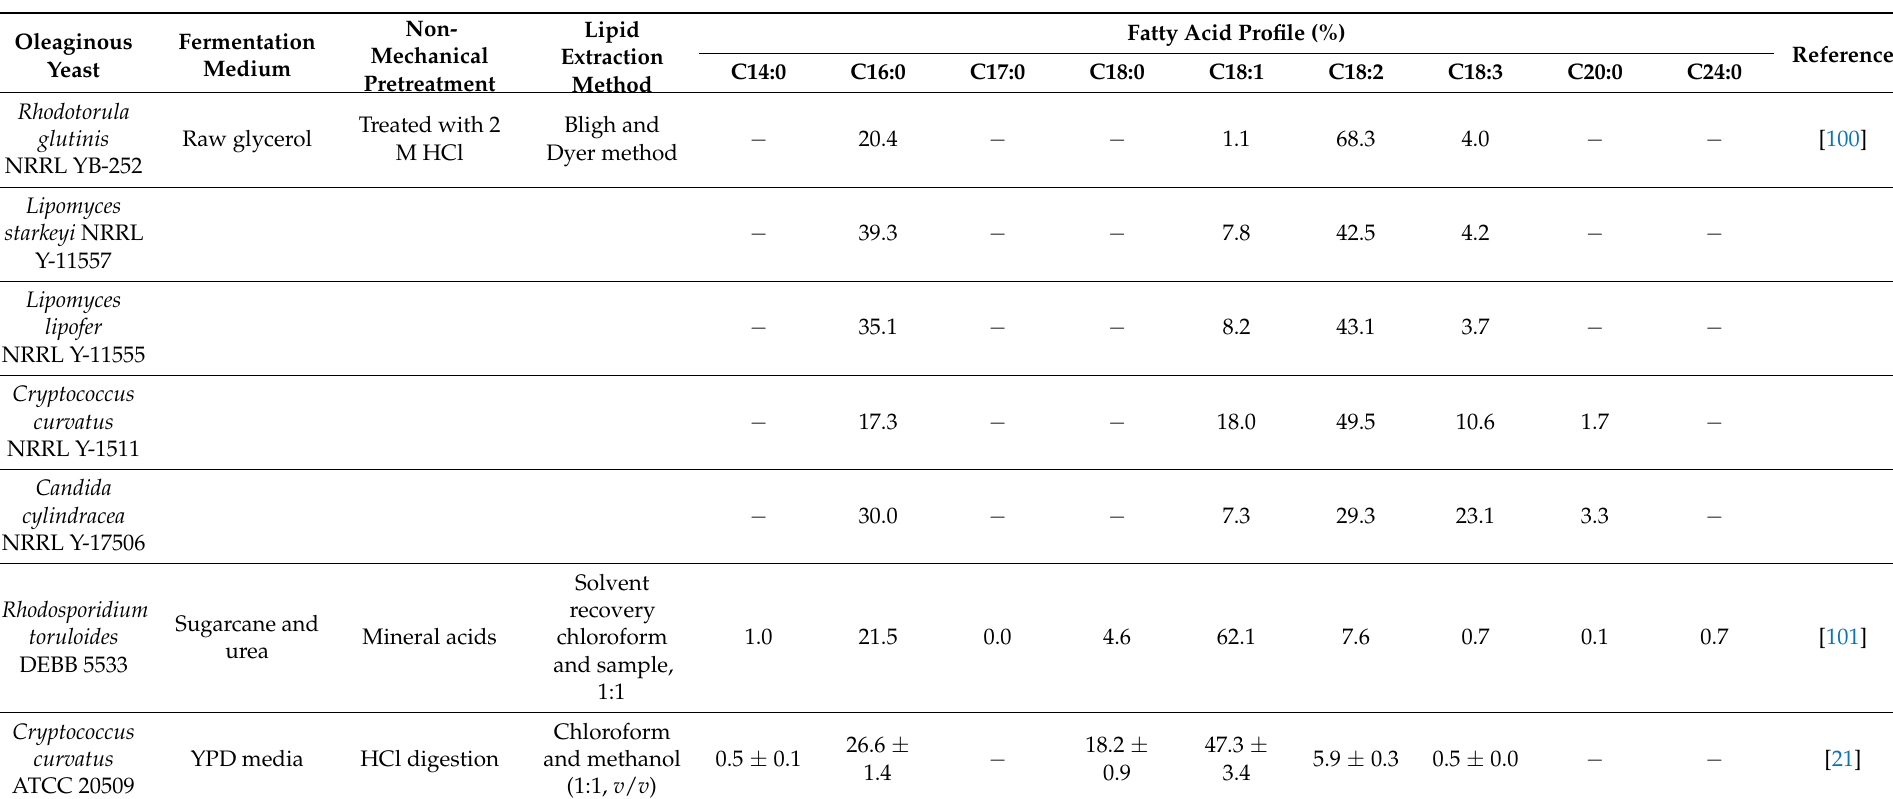
Table 3. Fatty acid profile of oleaginous yeasts extracted using various nonmechanical pretreatment/cell disruption and total lipid extraction